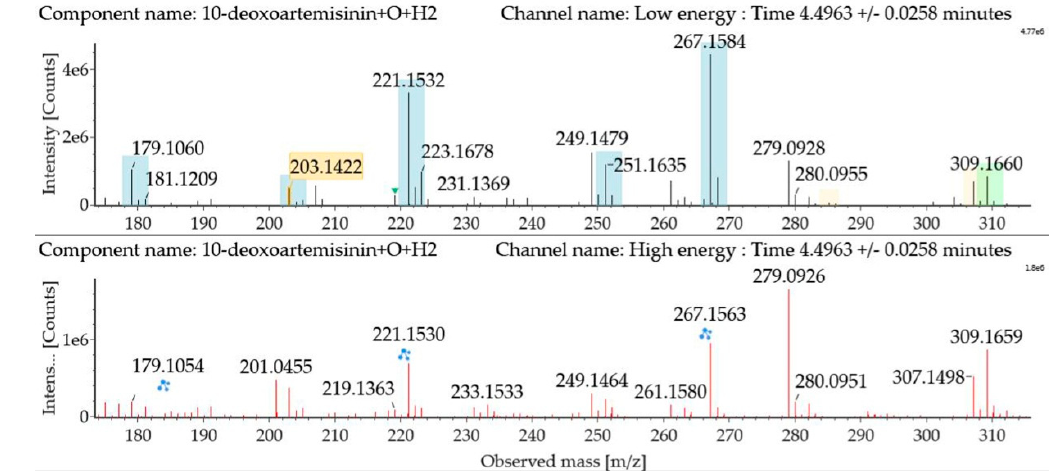
Figure 8. UPLC-ESI-Q-TOF-MS E spectra and the fragmentation diagram of hydroxylated hydrogenated 10-deoxoartemisinin.